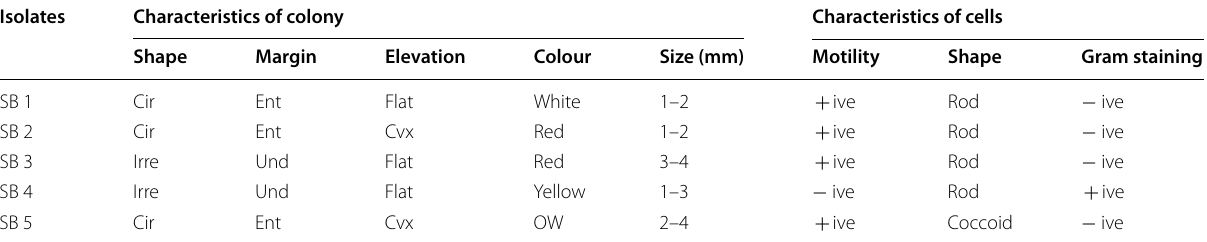
Table 2 Phenotypic characterization of stress-tolerant bacteria isolated from soil samples (CSSRI, 24 South Paragonas)